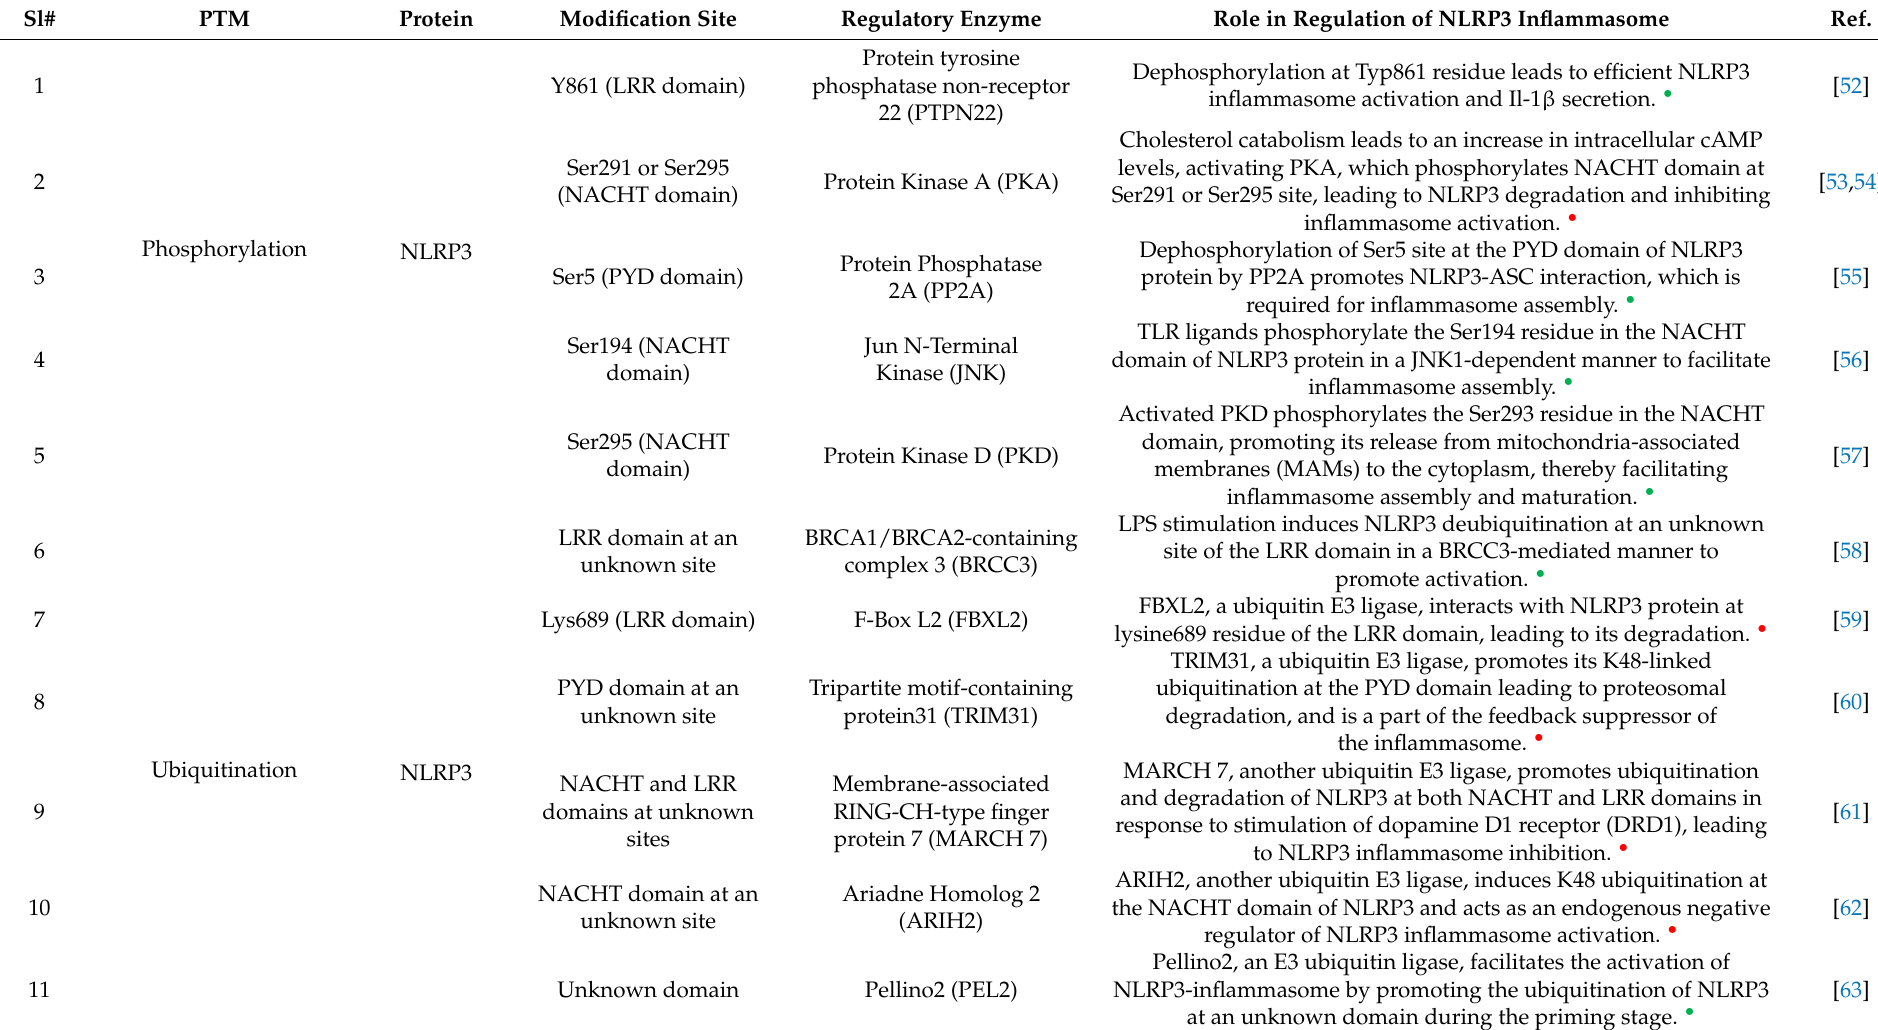
Table 1. Regulation of NLRP3-inflammasome activation through post-translational modification of NLRP3 and associated